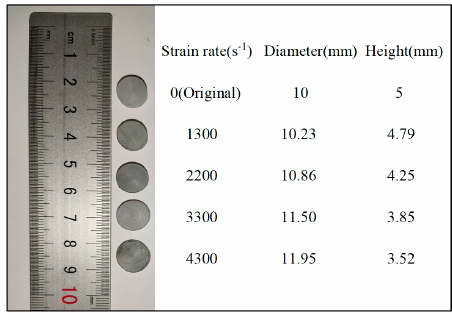
Figure 3. UHMWPE specimens before and after the SHPB experiment.